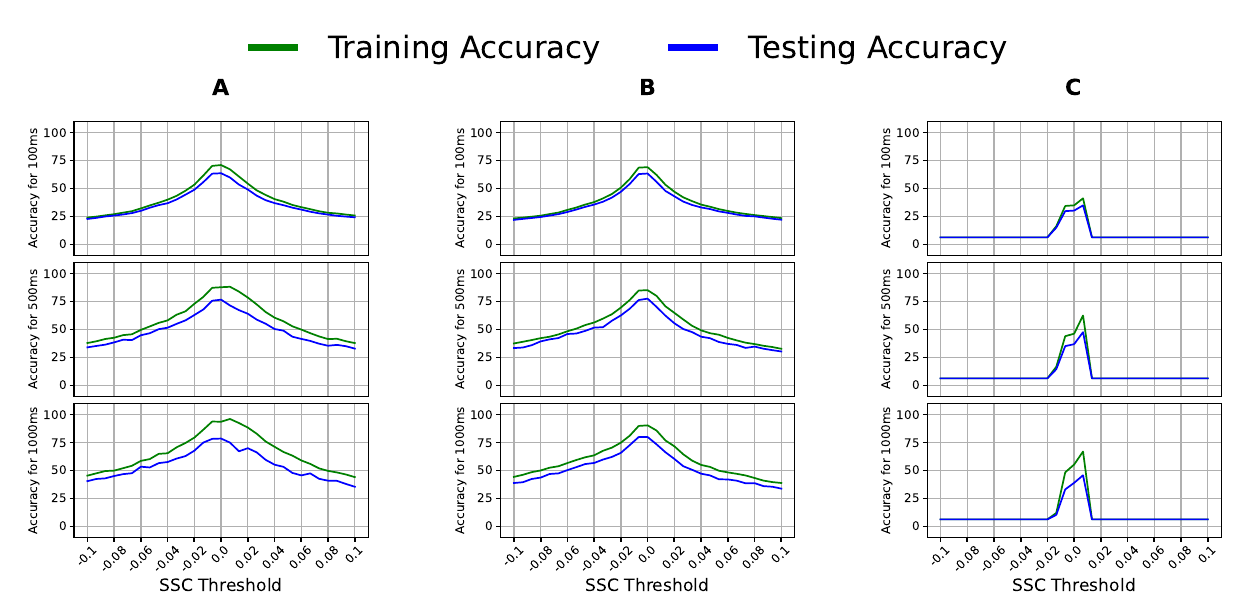
Figure 6. Classification accuracy of ( A ) logistic regression (LR), ( B ) linear discriminant analysis (LDA), and ( C ) quadratic discriminant analysis (QDA) with multiple SSC threshold values on varying window sizes using the sEMG data of Participants 4, 5, and 6.